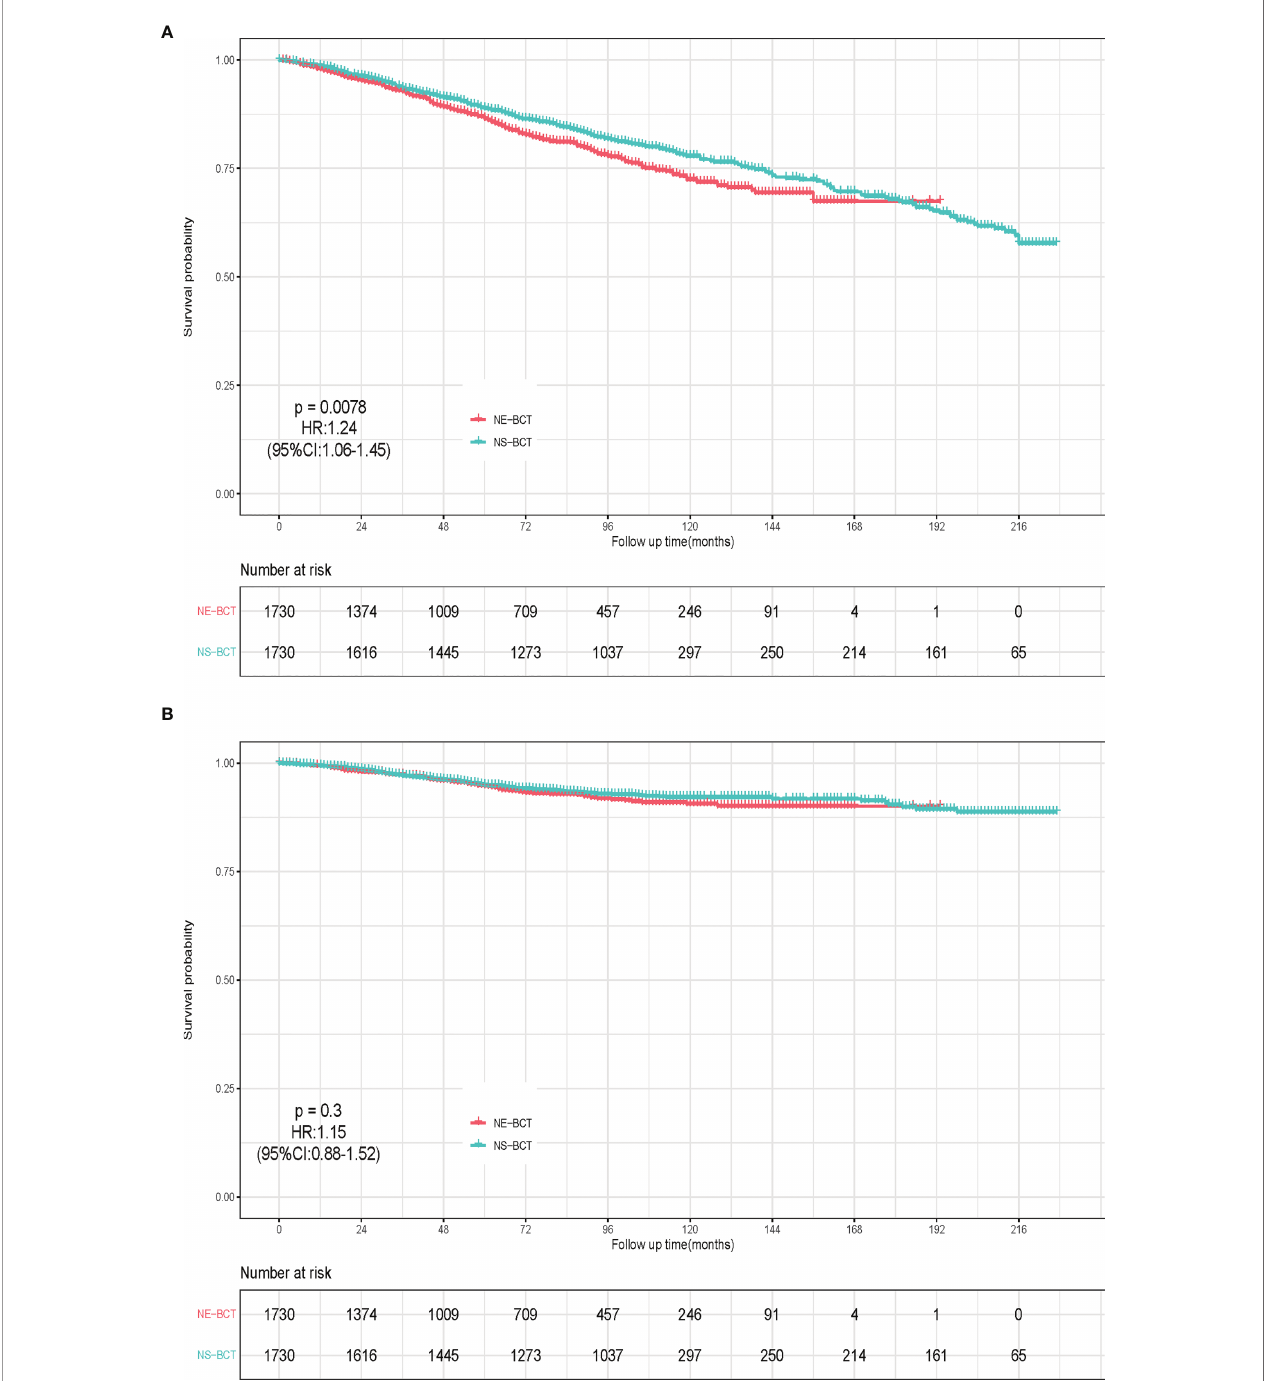
FIGURE 2 | Kaplan – Meier survival analysis for NE-BCT and NS-BCT female breast cancer patients. (A) Overall survival curves in NE-BCT group and NS-BCT group. (B) Breast-cancer-speci fi c survival curves in NE-BCT group and NS-BCT